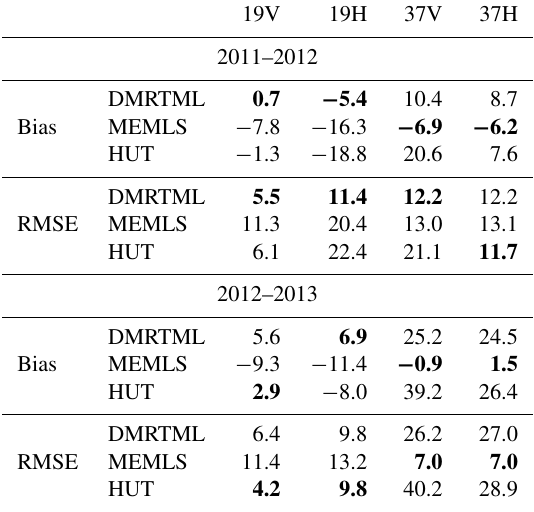
Table 6. Mean bias and RMSE in brightness temperature (K) sim- ulated by DMRT-ML (very sticky and less sticky), MEMLS (em- pirical and IBA oblate), and HUT (H87, R04, and K10) forced by 189 JIM–microstructure model combinations. Only days in the period from 1 November to 31 March, where all four fre- quency/polarisation measurements were available, were included in the analysis. Bold values indicate the lowest bias/RMSE for each frequency/polarisation.